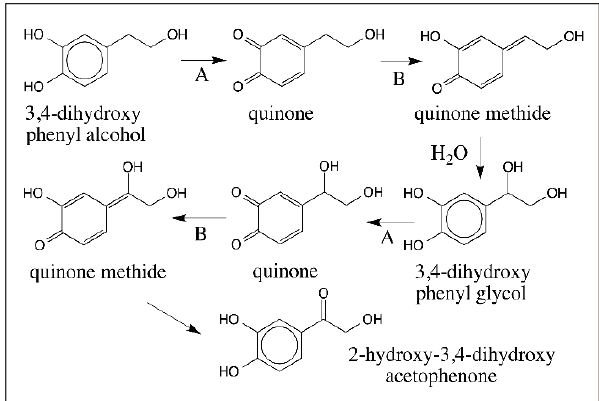
Figure 15. Oxidation of transformations of 3,4-dihydroxyphenethyl alcohol. Tyrosinase ( A ) catalyzes the oxidation of 3,4-dihydroxyphenethyl alcohol to its quinone, which can undergo either enzyme catalyzed isomerization or nonenzymatic isomerization ( B ) to its quinone methide. Water addition to this quinone methide and reoxidation of 3,4-dihydroxyphenyl glycol and yet another isomerization produces a transient quinone methide that readily yields 2-hydroxy-3,4-dihydroxy acetophenone as the final product.